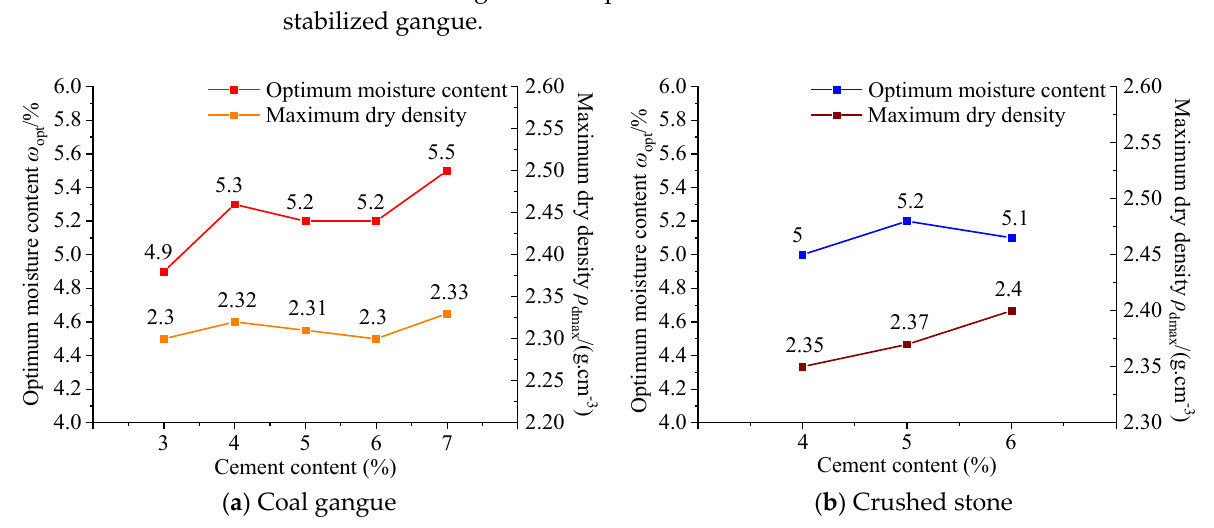
Figure 15. Test results of compaction test of mixture.